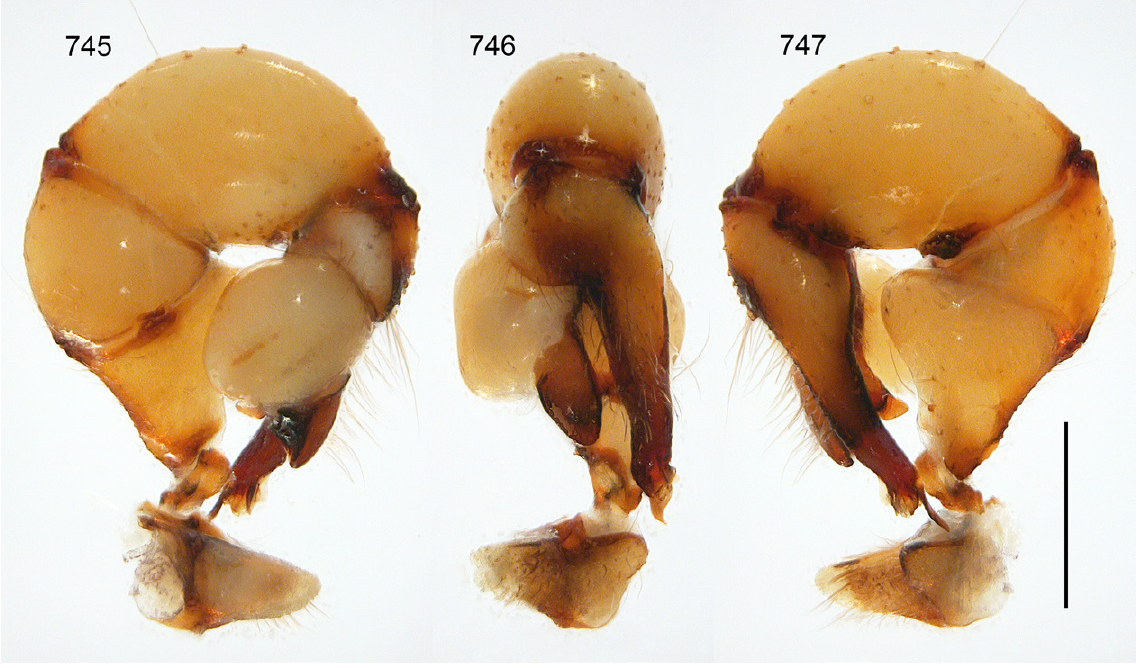
Figs 745–747. Crossopriza srinagar sp. nov.; holotype male from India, Srinagar (ZFMK Ar 22449); left palp, prolateral, dorsal, and retrolateral views. Scale bar = 0.5